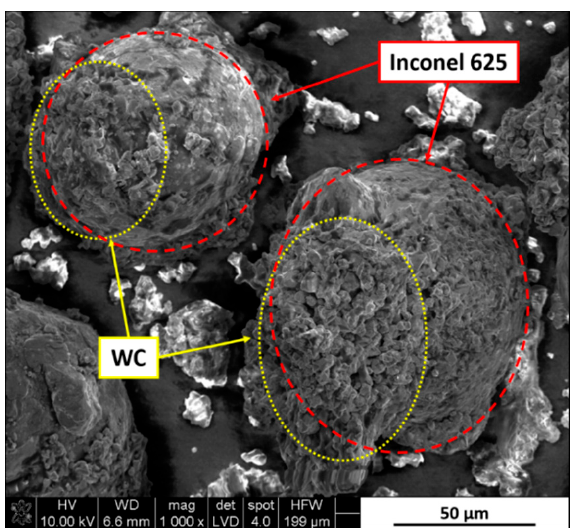
Figure 2. Spherical Inconel 625 particle surface covered by agglomerates of fine tungsten carbide (WC) grains with dextrin binder.